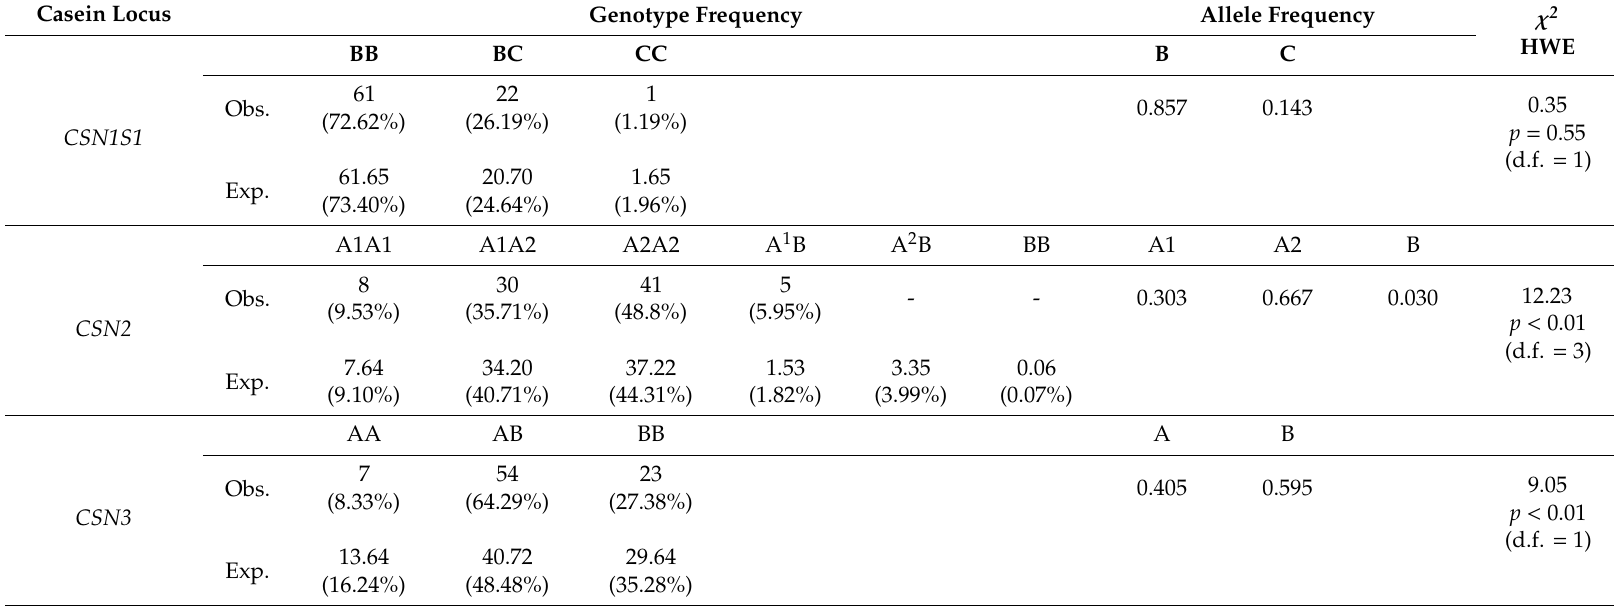
Table 1. Observed and expected numbers and percentages (in brackets) of genotypes at CSN1S1 , CSN2 and CSN3 loci, allele frequencies and Hardy-Weinberg Equilibrium (HWE) in the sample of Agerolese